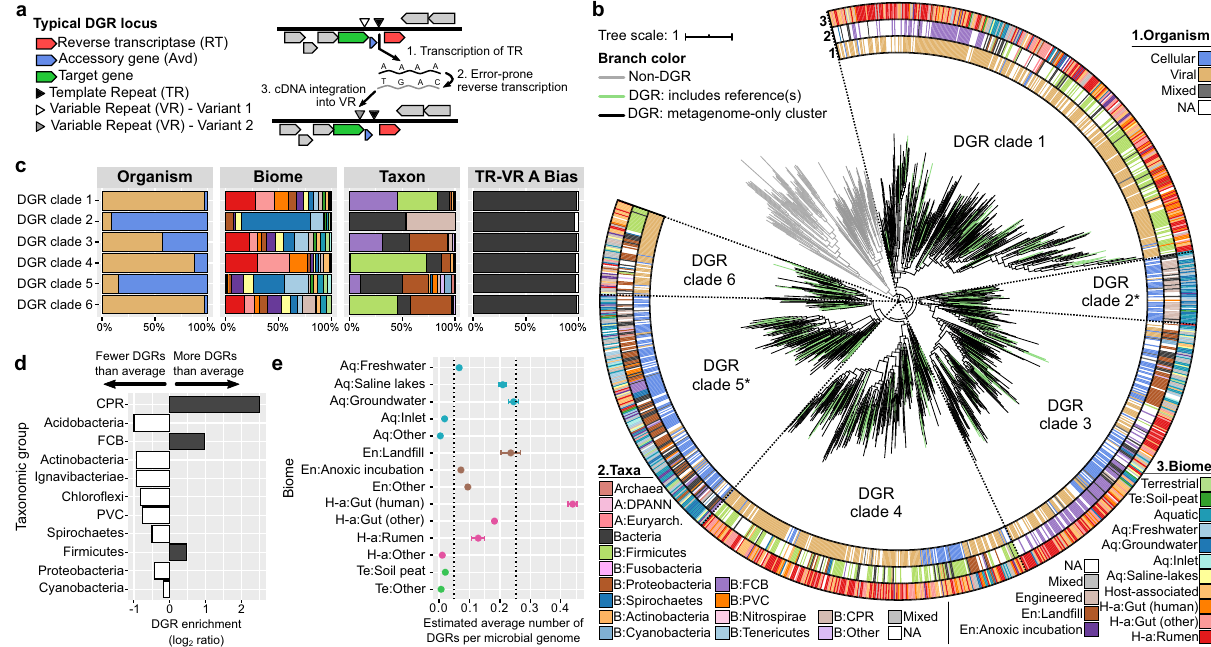
Fig. 1 Distribution of DGR diversity across organisms, biomes, and taxa. a Schematic representation of the DGR mutagenic retrohoming process. The main components of a DGR are highlighted in colors, and the three main steps of the process are indicated directly on the diagram. TR, Template repeat/ region. VR, Variable repeat/region. b Phylogeny of DGR and non-DGR reverse transcriptases (RT). RT protein sequences were fi rst grouped into “ RT clusters ” , and a representative for each cluster was included in the tree building process (see “ Methods ” ). Branches are colored according to the type of RT in the corresponding cluster. All nodes with support <50% were collapsed. From inside to outside, the outer rings display the consensus genome type, taxonomic classi fi cation, and biome of each RT cluster. CPR: Candidate Phyla Radiation. DPANN Diapherotrites , Parvarchaeota , Aenigmarchaeota , Nanoarchaeota , Nanohaloarchaeota , FCB Flavobacteria , Fibrobacteres , Chlorobi , Bacteroides, PVC Planctomycetes , Verrucomicrobia , Chlamydiae , Aq aquatic, Te Terrestrial, En Engineered, H-a Host-associated. NA corresponds to cases for which the feature could not be estimated (see Supplementary Fig. 2). c Distribution of each feature at the RT OTU level across DGR clades. The colors used in the bar chart are identical to panel ( b ), and NA values were not included. d Enrichment of DGR-encoding genomes across taxa. The total number of genomes observed across metagenome assemblies was calculated